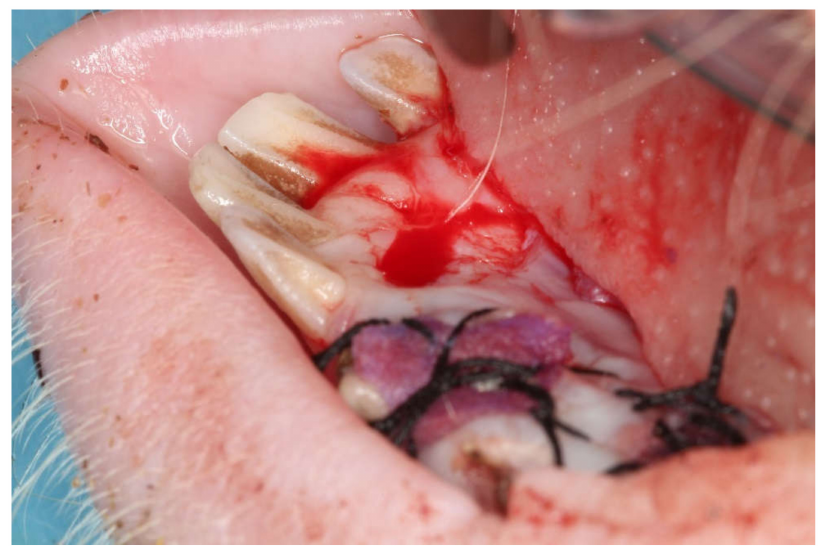
Figure 2. Post-surgical photograph showing: one surgical site to be allowed to heal by second intention; two surgical sites on which ADMGs have been placed randomly and sutured